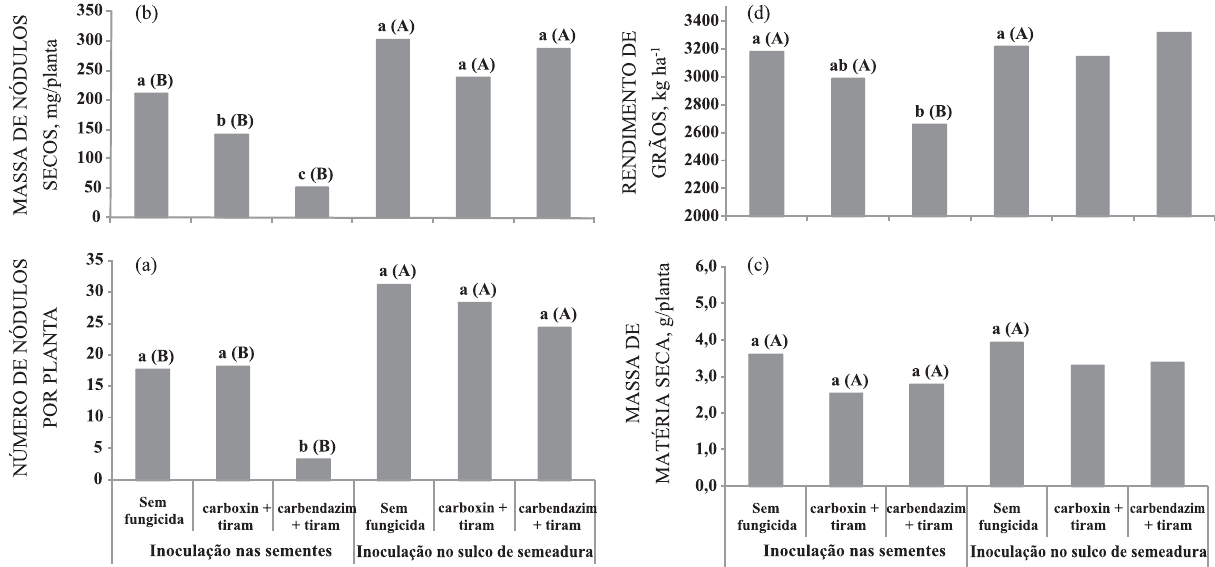
Figura 1. Rendimento médio de grãos de soja (anos de 2006 e 2007) em avaliações de métodos de inoculação com Bradyrhizobium no Cerrado de Roraima. Análise realizada conjuntamente, considerando uma fatorial entre os métodos de inoculação, fungicidas e os dois anos. Médias seguidas de mesma letra minúscula, para uma mesma variável e método de inoculação, e maiúscula, para uma mesma variável e fungicida, não diferem entre si pelo teste de Tukey a 5